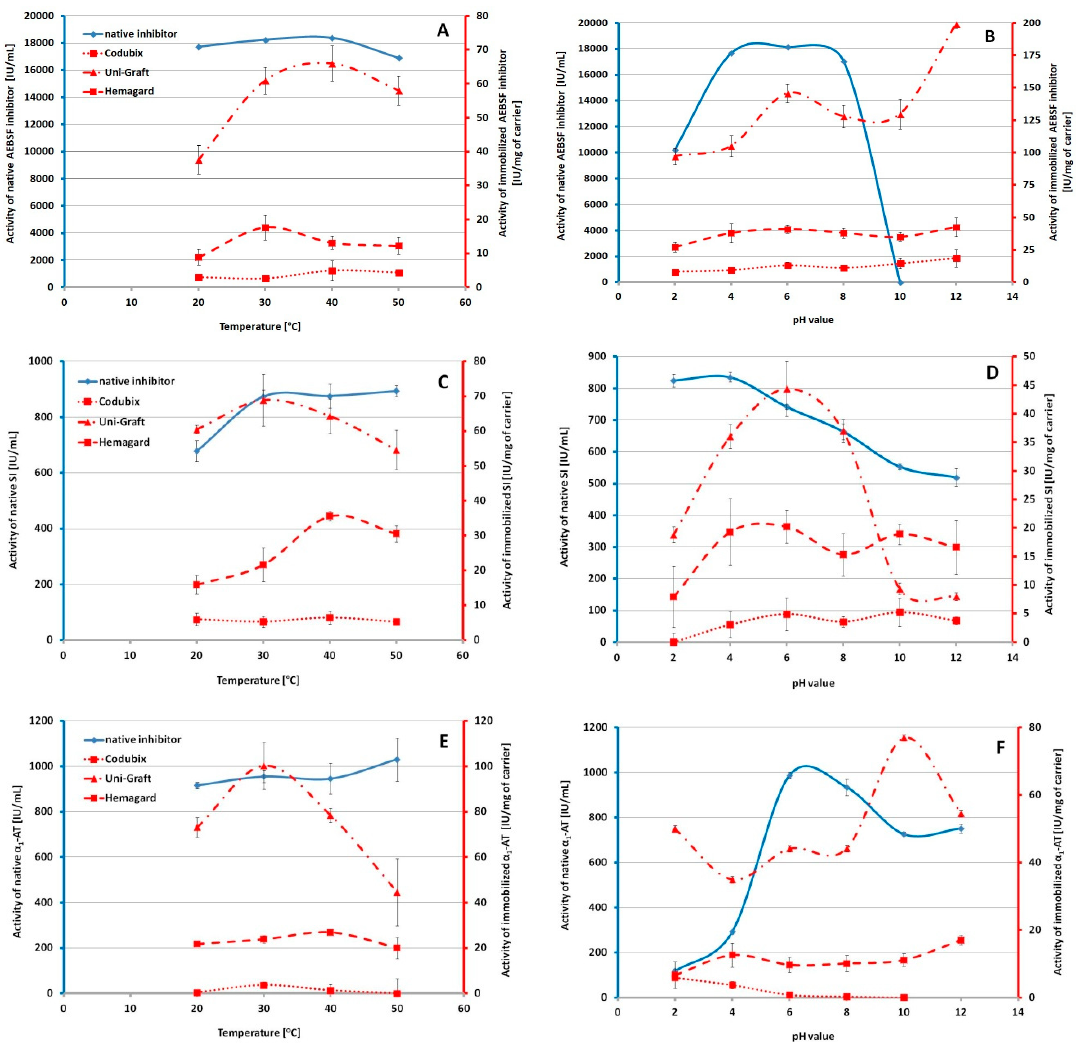
Figure 1. Inhibitor activity profiles after incubation in the environment with different values of temperature and pH—( A ) and ( B ) AEBSF inhibitor; ( C ) and ( D ) SI; ( E ) and ( F ) α 1 -AT.